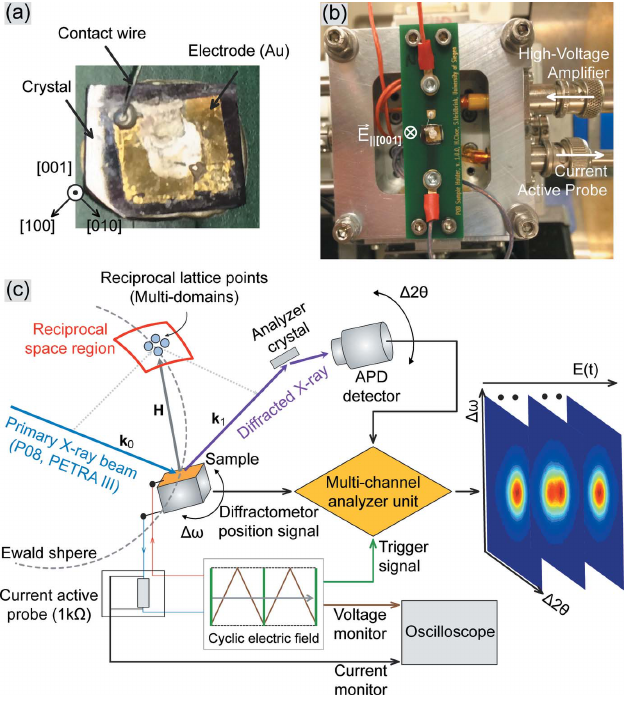
Figure 1 The experimental setup for stroboscopic high-resolution reciprocal space mapping. ( a ) As-grown and prepared sample, with the crystallographic orientation of the edges shown. ( b ) A view of the sample holder for application of the electric field. ( c ) A flow chart of the stroboscopic data- acquisition process. The diffracted signal is collected using a single- photon-counting APD detector placed behind an Si(111) analyser crystal in ! versus 2 (cid:2) scan mode. A cyclic 100 Hz triangular-shaped electric field is applied to the sample. Detector signals are processed using a custom- built stroboscopic data-acquisition